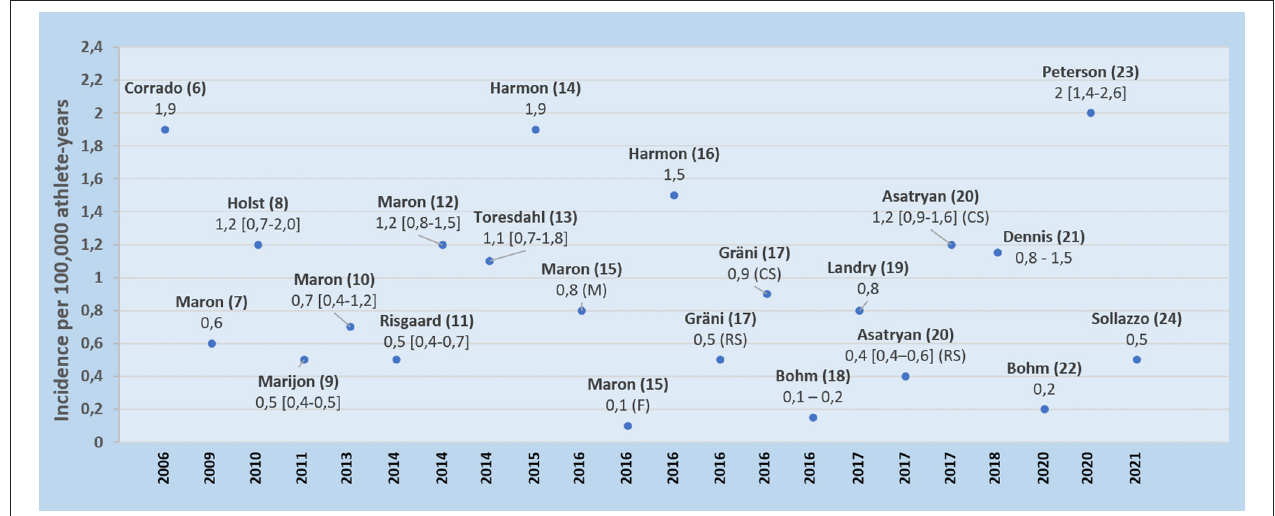
FIGURE 1 | Representation of incidences of sports-related sudden cardiac arrests by ascending date of publication. Mean incidence [95% CI included where available]. CS, competitive sports; F, female; M, male; RS, recreational